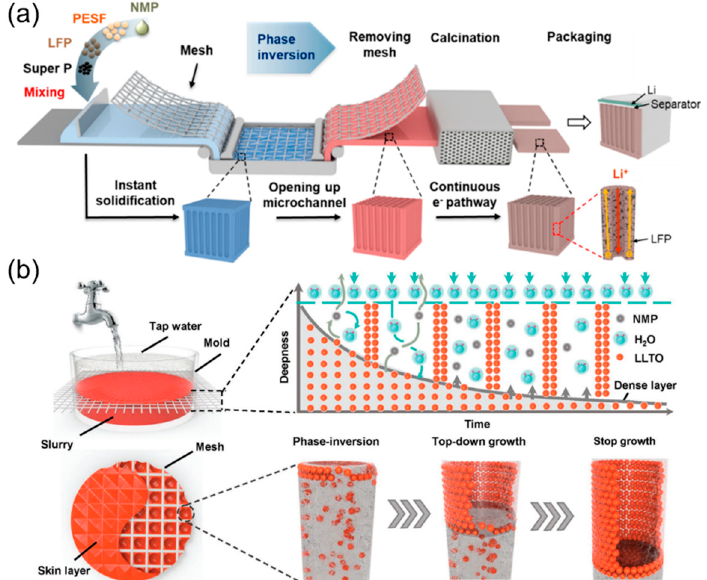
Figure 4. ( a ) A bilayer LFP electrode fabricated by the templated phase inversion method. Repro- duced with permission from ref. [54]. Copyright 2021, ACS Publications. ( b ) LLTO solid electrolyte with vertically aligned microchannels made by the templated phase inversion method. Reproduced with permission from ref. [57]. Copyright 2018,